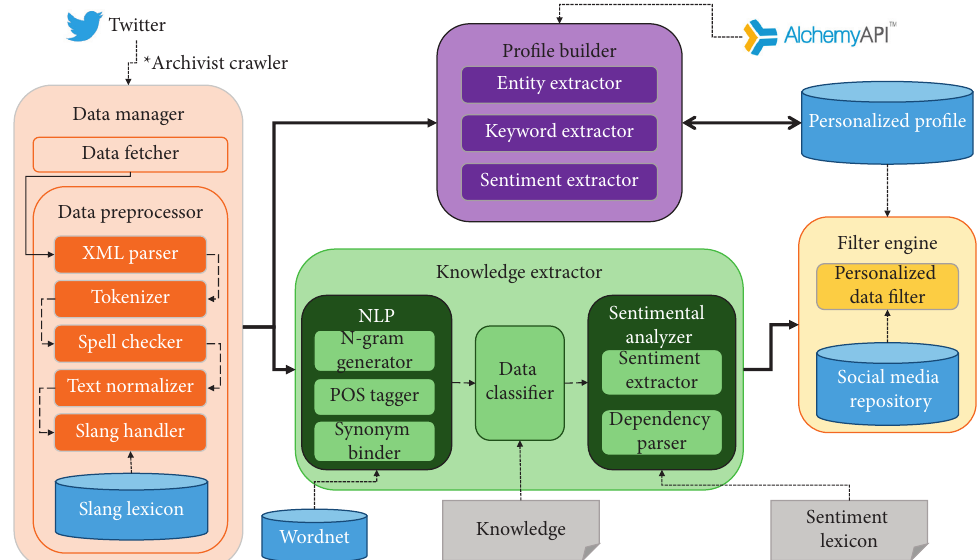
Figure 1: The proposed system architecture for profiling and tweet